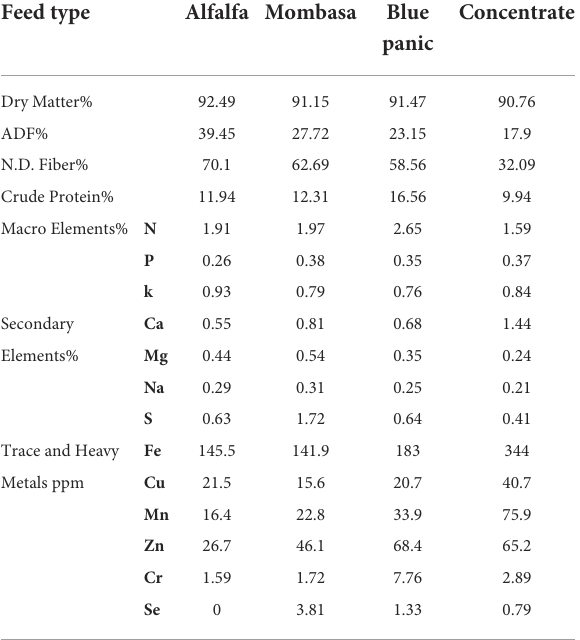
TABLE 1 Nutrient composition of Mombasa, blue panic, alfalfa, and commercial concentrate feed ( n = 5/feed type). Feed